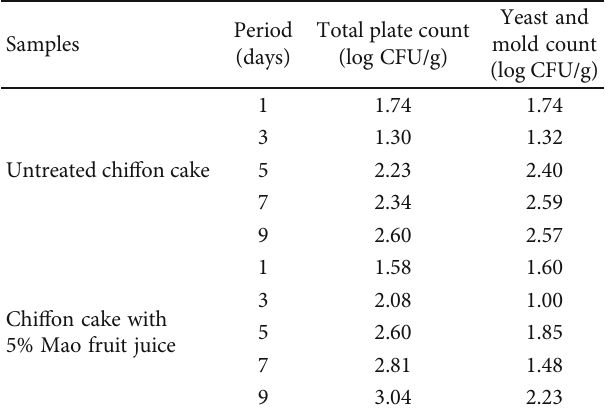
Table 5: Microbial count of chi ff on cake during storage at 4 ° C for 9